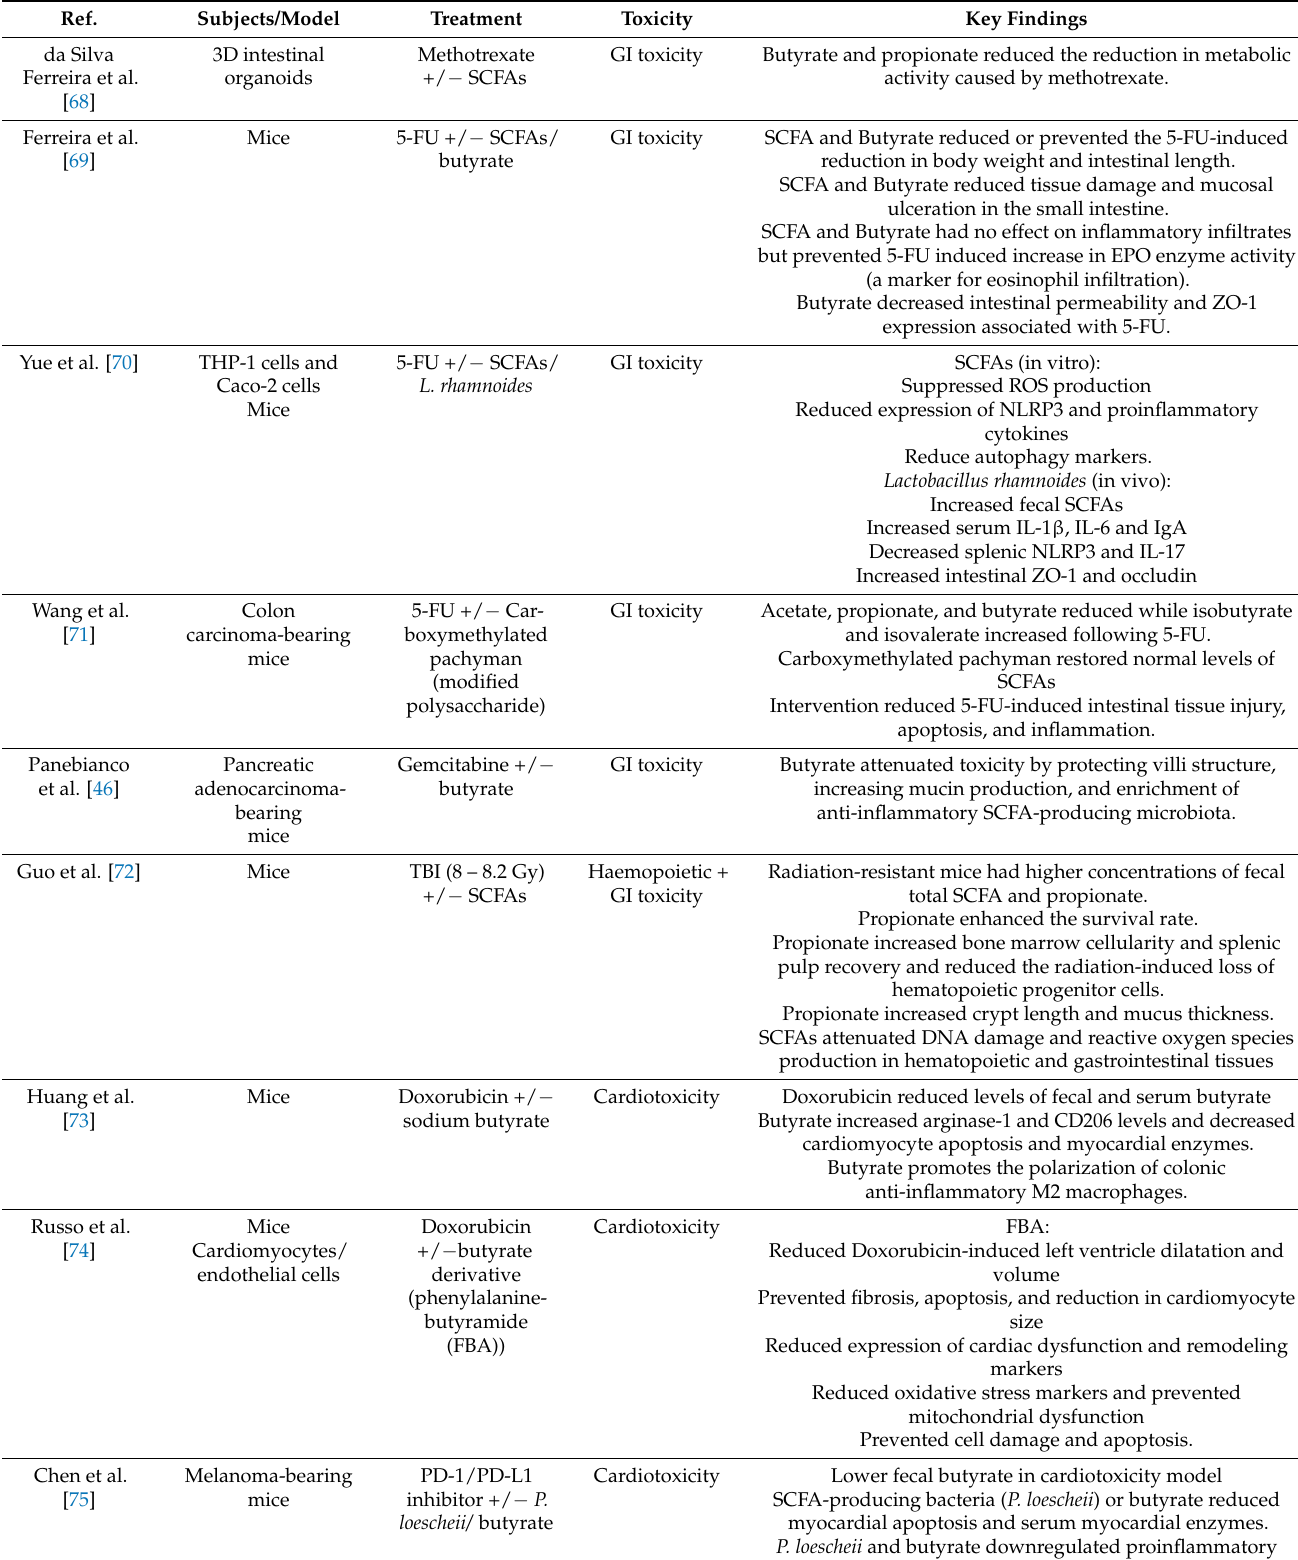
Table 2. Impact of SCFA-based interventions on cancer treatment